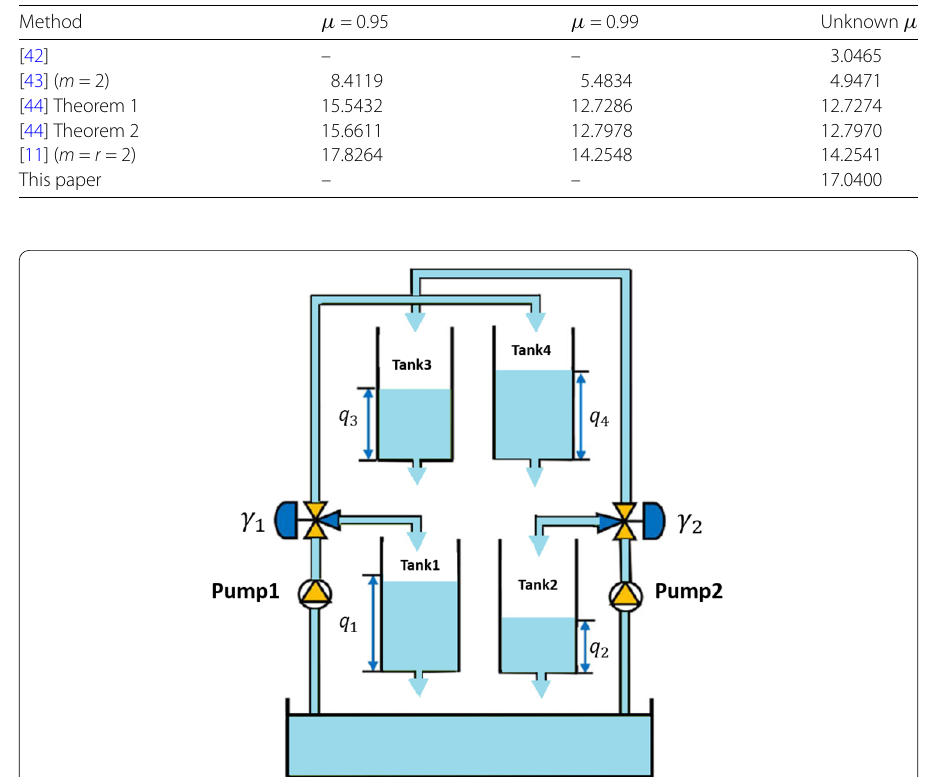
Figure 6 Schematic representation of the four-tank system. Source: Johansson [45]